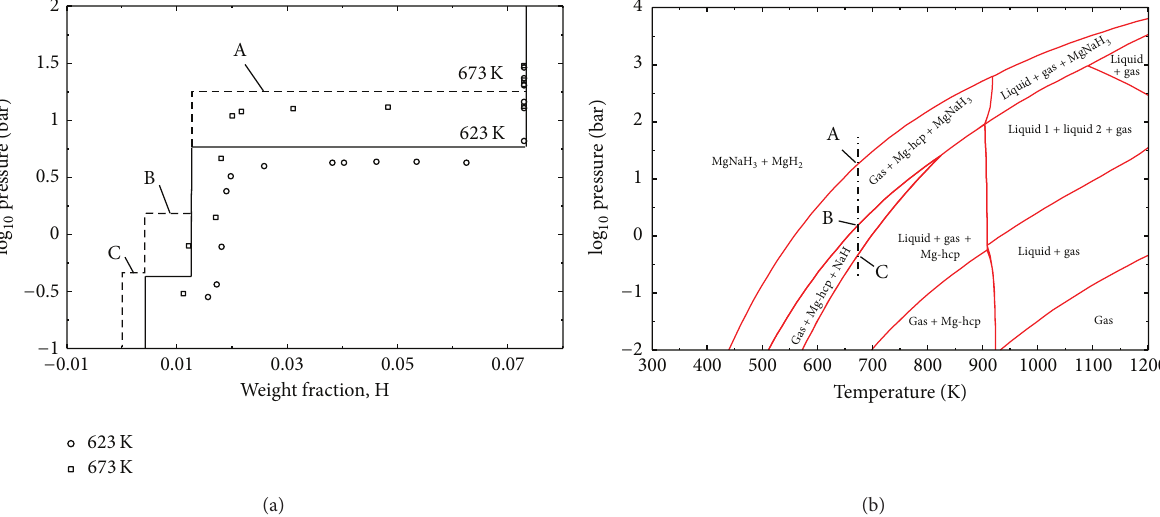
Figure 14: (a) Calculated P-C isotherm for MgH 2 + 10wt.% NaH at 623 and 673 K compared to experimental data [19]. (b) Calculated pressure-temperature diagram for MgH 2 + 10wt. % NaH.